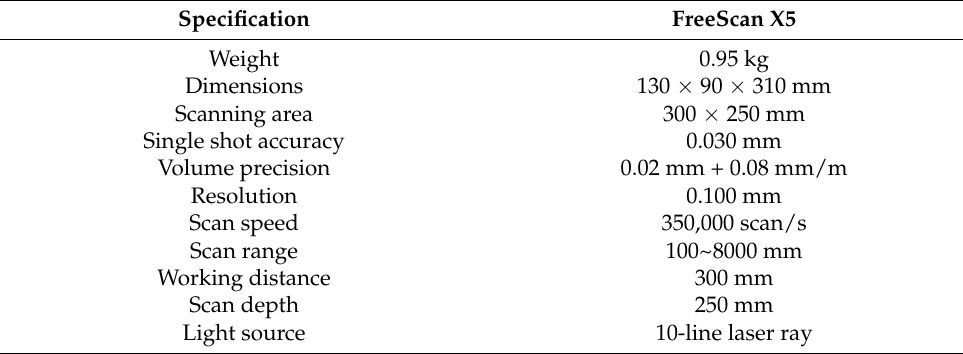
Figure 5. Handheld laser scanner of FreeScan X5. Table 2. Specifications of the handheld 3D laser scanner (HLS) FreeScan